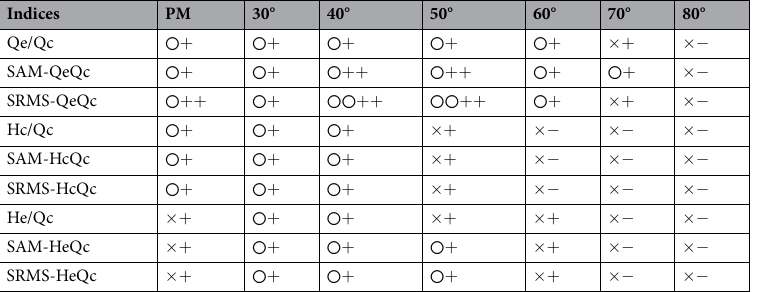
Table 4. Statistic difference and effect size of the H/Q ratios, the SAM and SRMS indices by knee angle ( N = 46). Single circle ( ○ ) denotes significant differences at P < 0.05, double circle ( ○○ ) denotes significant differences at P < 0.01, and single cross ( × ) denotes no statistical significant differences. Double transverse line ( − ) denotes very small effect size at Cohen’s d is less than 0.20, single transverse line ( − ) denotes small effect size at Cohen’s d from 0.20 to 0.50, single cross ( + ) denotes medium effect size at Cohen’s d from 0.50 to 0.80, an d double cross ( ++ ) denotes large effect size at Cohen’s d over 0.80. H/Q, hamstring to quadriceps muscle strength ratios; PM, peak moment; SAM, single-to-arithmetic-mean form indices; SRMS, single-to-root-mean-square form indices; Qe, quadriceps eccentric contraction;